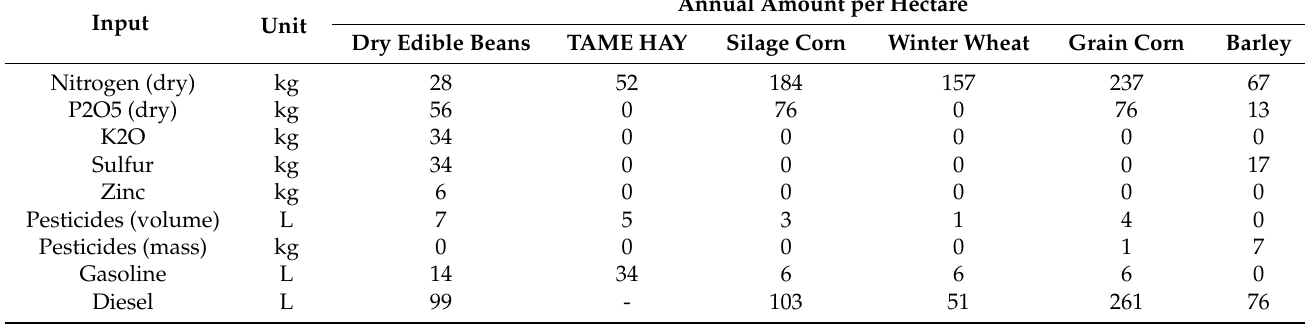
Table A8. Clarksburg